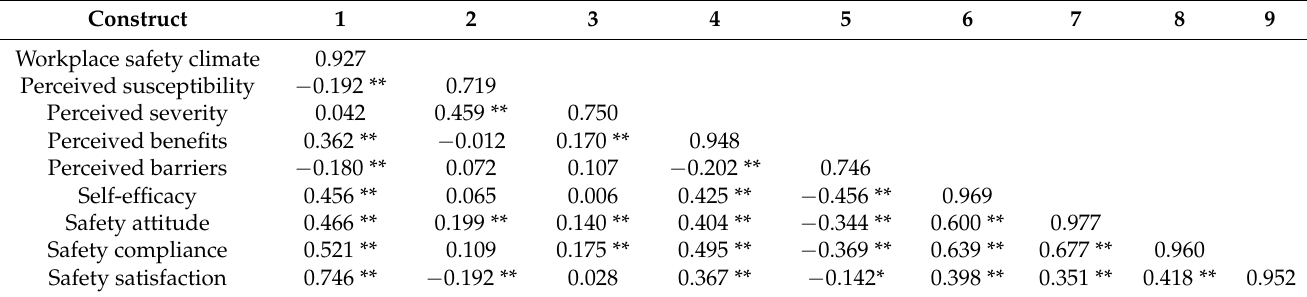
Table 3. Results of discriminant validity analysis.